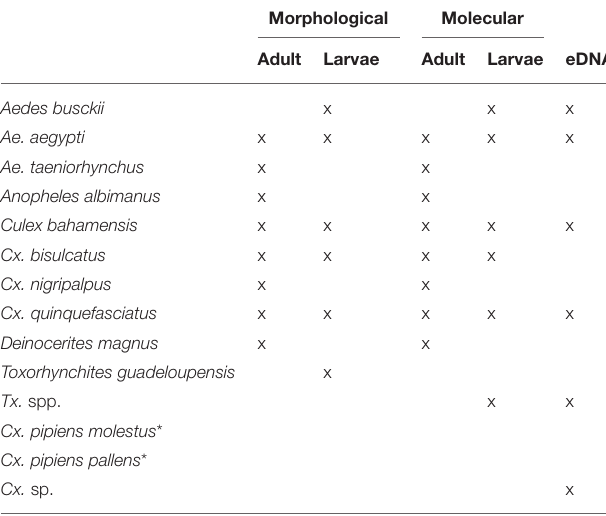
TABLE 1 | Identified species using each of the different